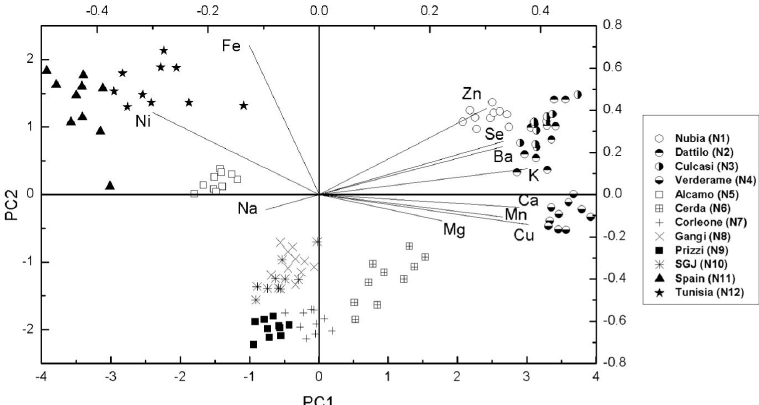
Figure 2 . Score ( left and bottom axes) and loadings ( right and top axes) plot showing the results of the PCA performed on all the analyzed garlic